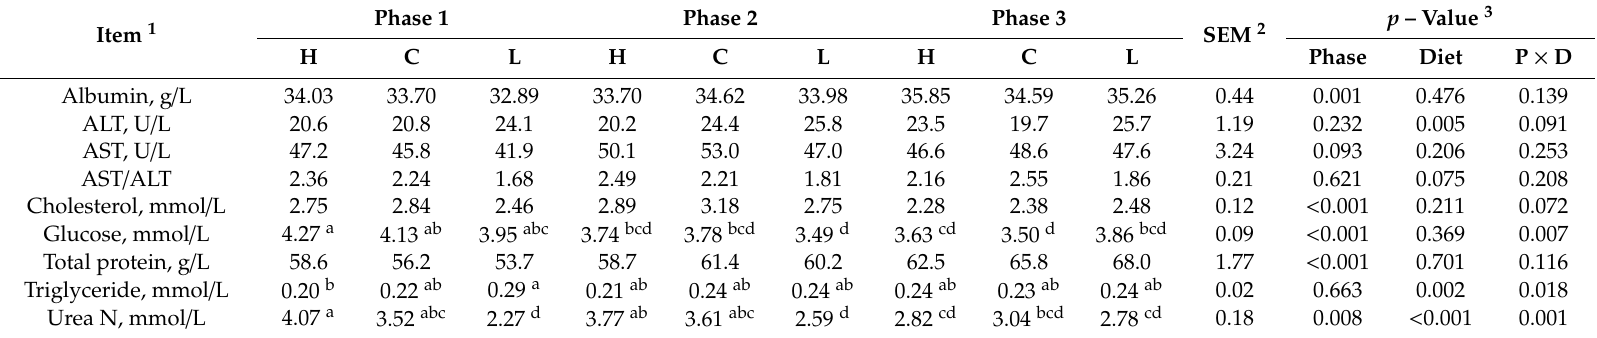
Table 3. E ff ects of dietary nutrient density on plasma biochemical parameters in the whole fattening phases of Holstein steers.